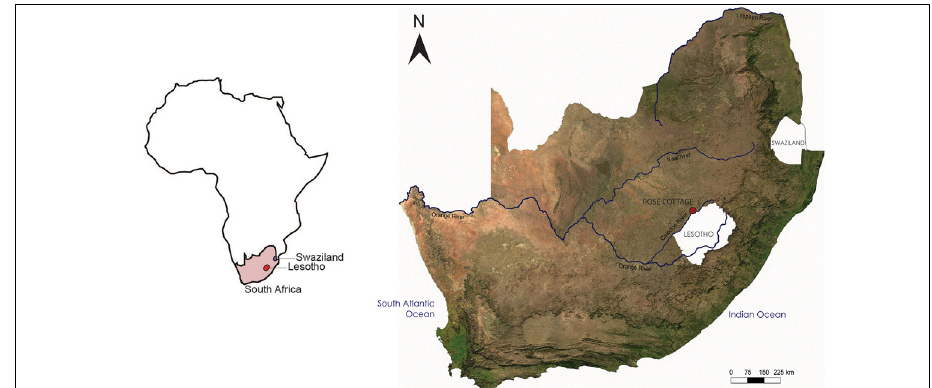
Figure 1: Location of Rose Cottage Cave in South